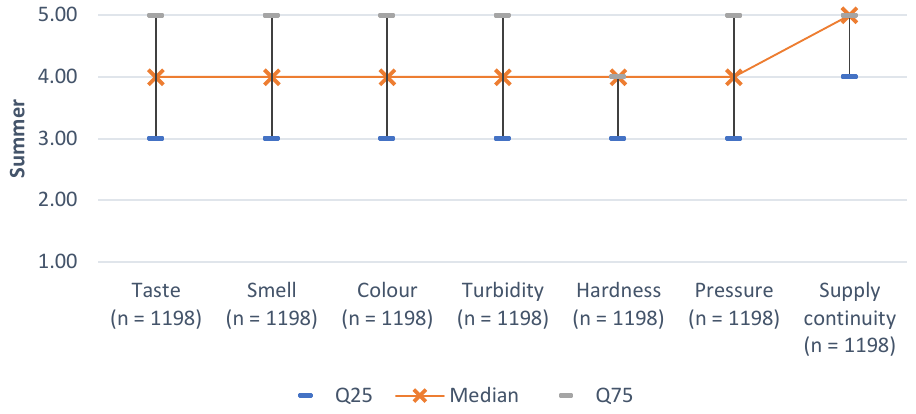
Figure 3. Respondents’ evaluation of individual tap water parameters during the summer period.